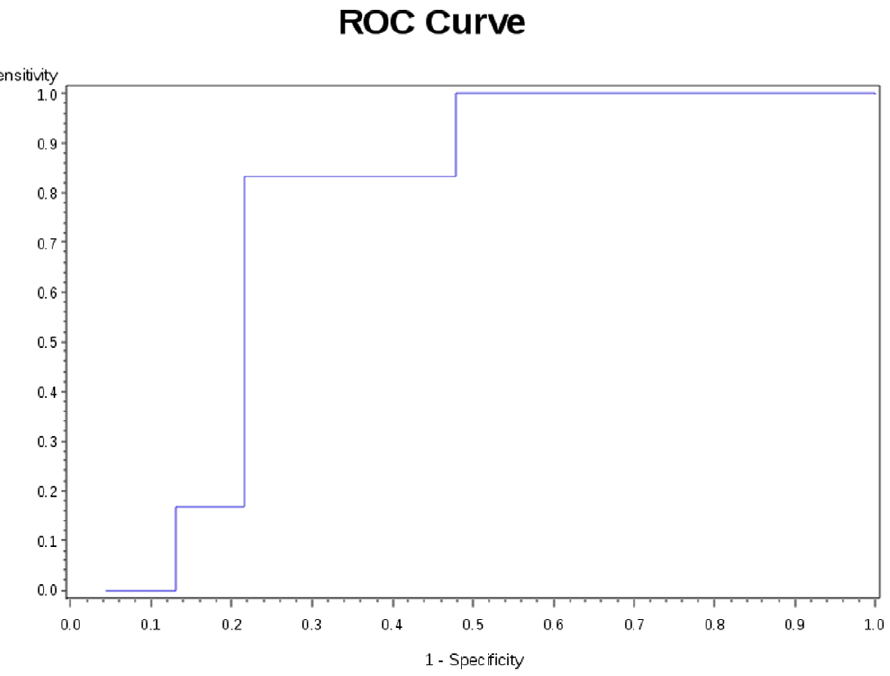
Figure 7. ROC curve for CCR7 + Treg and BOS. The ROC curve is based upon a logistic regression model for CCR7 + Treg predicting BOS outcome, which excludes samples collected after the diagnosis of BOS. The p-value for the global null hypothesis is 0.04 and the area under the curve (AUC) is 0.75; the model has good predictive value.